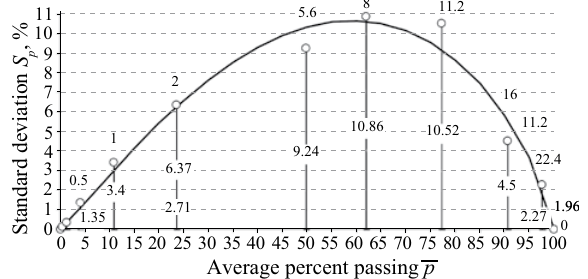
Fig. 4. Correlation between the parameters of RAP-3 non- extracted granules gradation variation ( s p ) and position ( p